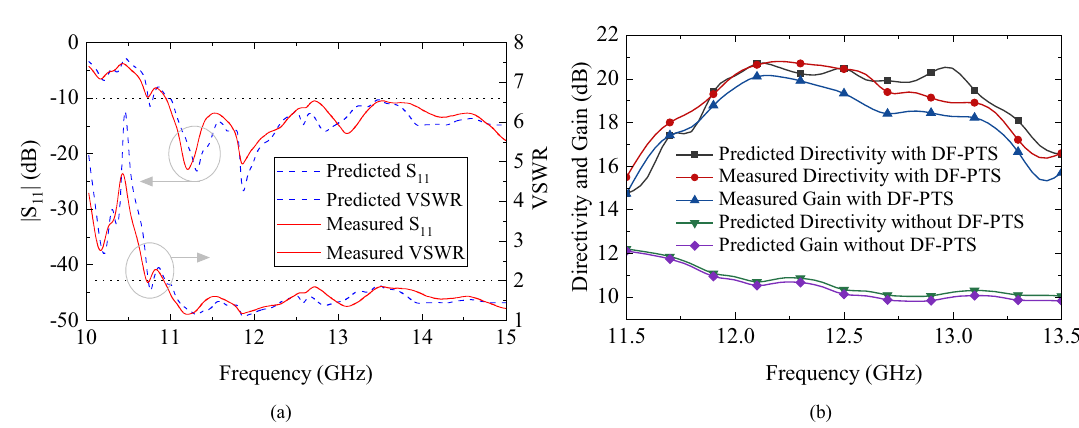
Figure 14. Measured and predicted ( a ) input impedance matching of the RCA with DF-PTS, and ( b ) peak directivity and peak gain of the RCA with and without with unit-cell boundary conditions when used in DF-PTS, placed in the near-field region of RCA, demonstrated anticipated phase correction. It is because the phase variation within the area equivalent to the size of the unit cell even within the near-field region is less than 45°. Although the DF-PTS was designed at a single operating frequency, its performance was measured over a broad frequency range. The voltage standing wave ratio (VSWR) and | S 11 | of the RCA with DF-PTS are plotted in Fig. 14a. The measured 10-dB return loss bandwidth is approximately 46% (from 11.0 GHz to 17.5 GHz), which is in good agreement with what was predicted from a simulation. The measured and predicted peak directivity and peak gain of the RCA with and without the DF-PTS over a large frequency range are shown in Fig. 14b. The measured maximum gain of 20.1 dBi is noted at 12.2 GHz. At this frequency, the aperture efficiency of the RCA with DF-PTS is 24.0%. This is a dramatic increase compared to the 2.7% aperture efficiency of the RCA without the DF-PTS. The measured 3-dB directivity bandwidth of the RCA with DF-PTS is 11.7–13.2 GHz, which is 12.0% of the center operating frequency. The measured gain bandwidth of RCA with DF-PTS is 11.7–13.2 GHz